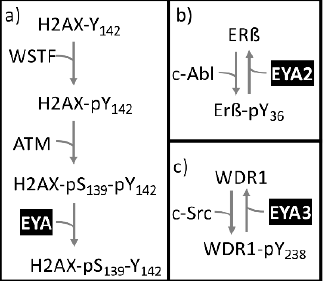
Figure 4. Known and proposed substrates of the eyes absent (EYA) protein tyrosine phosphatase (PTP) activity.( a ) H2AX-Y142, ( b ) ER β and ( c )WDR1.